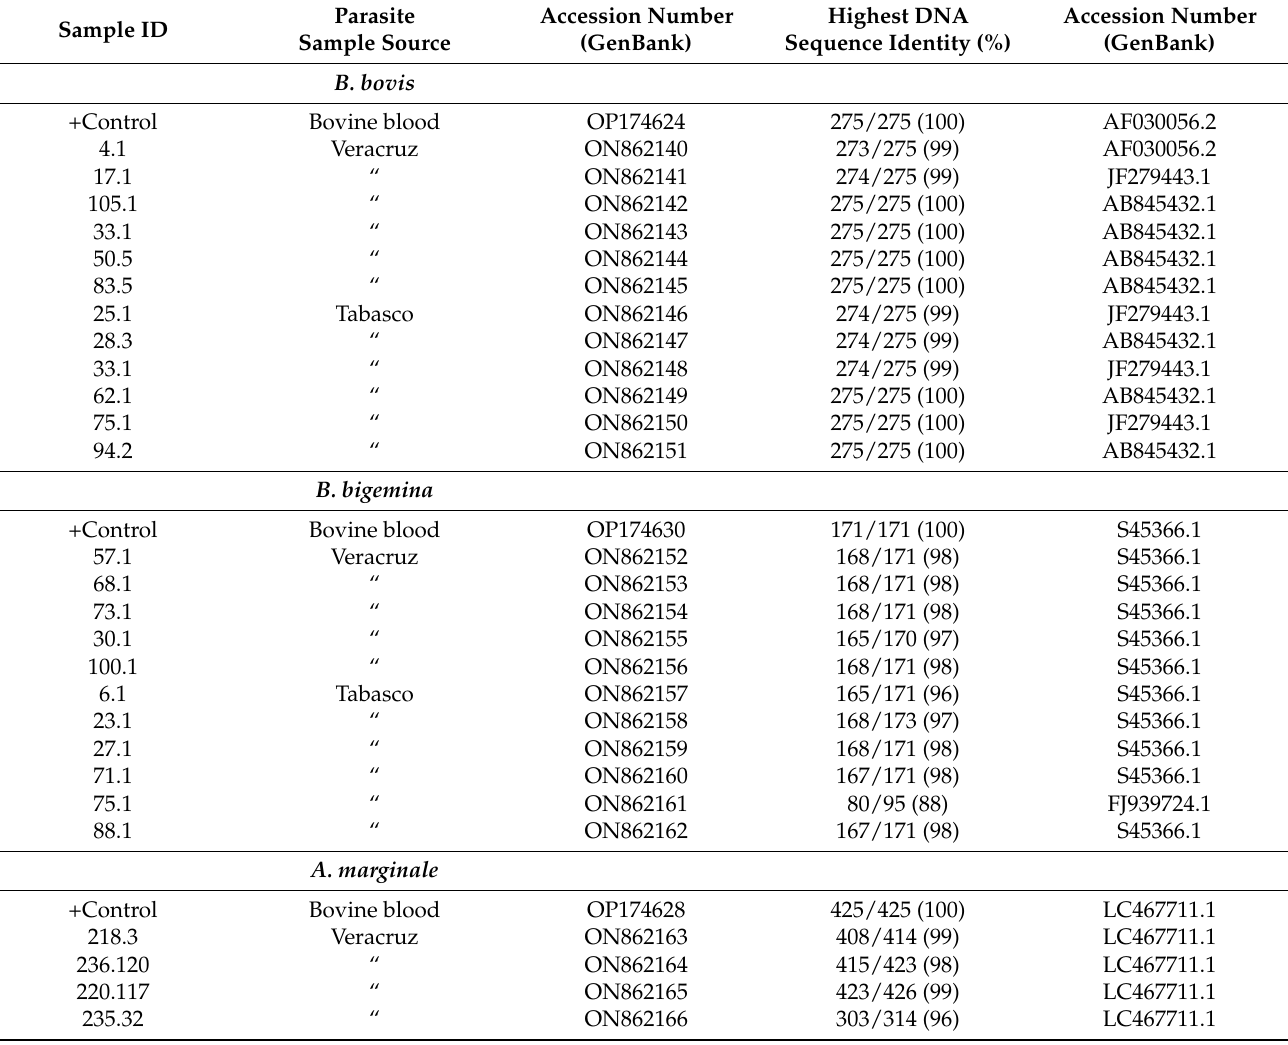
Table 3. Sequence identities of DNA samples from water buffaloes in Mexico, analyzed using